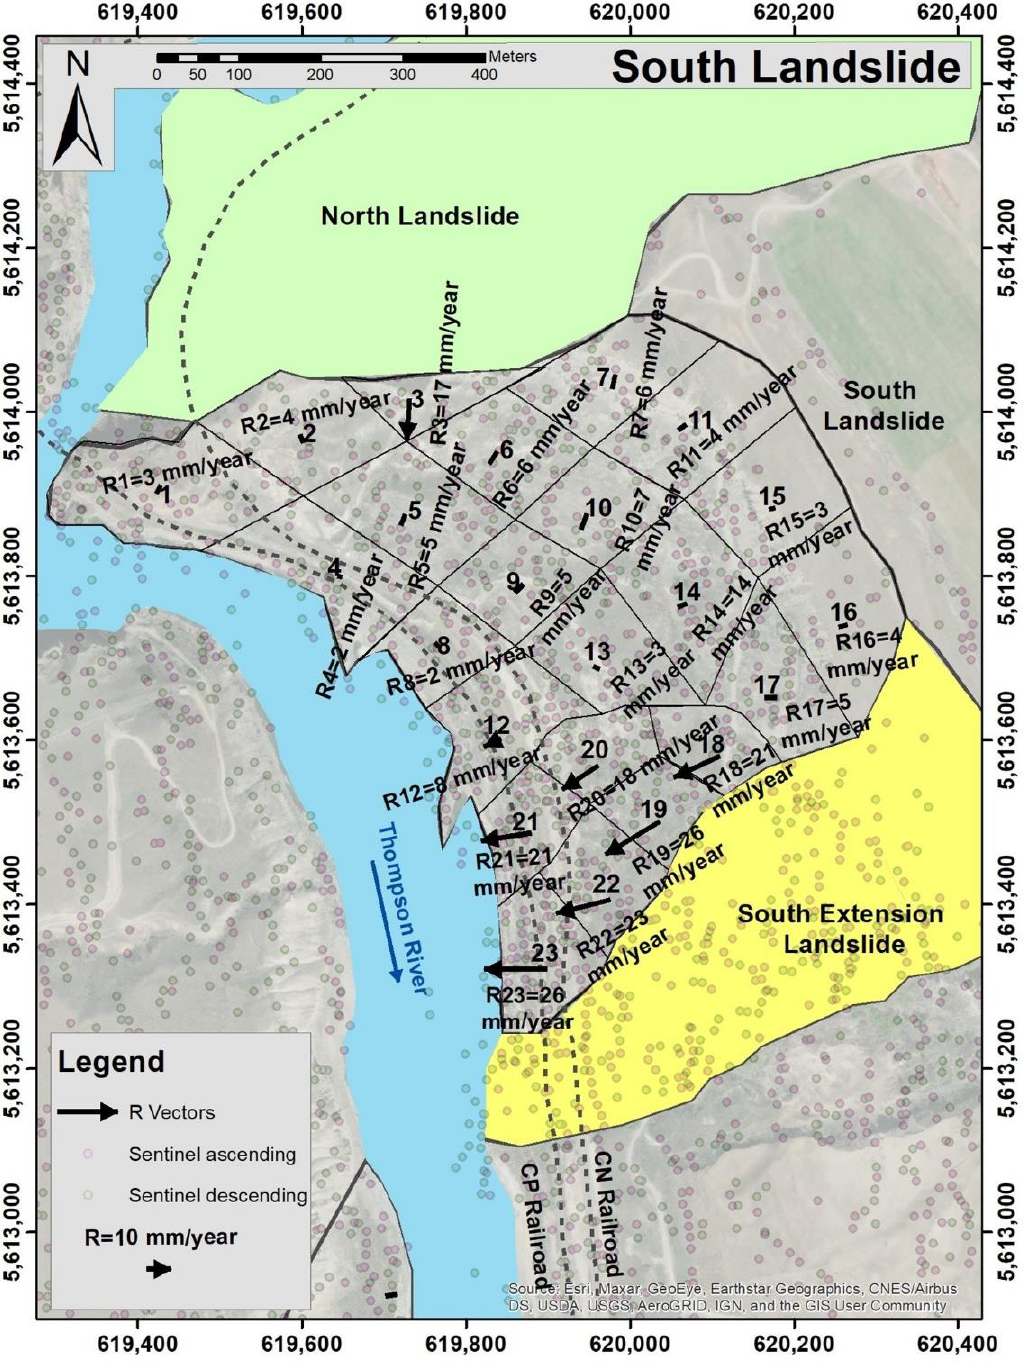
Figure 14. Calculated horizontal component of R vectors for divided parts within the South landslide extent in plan-view.